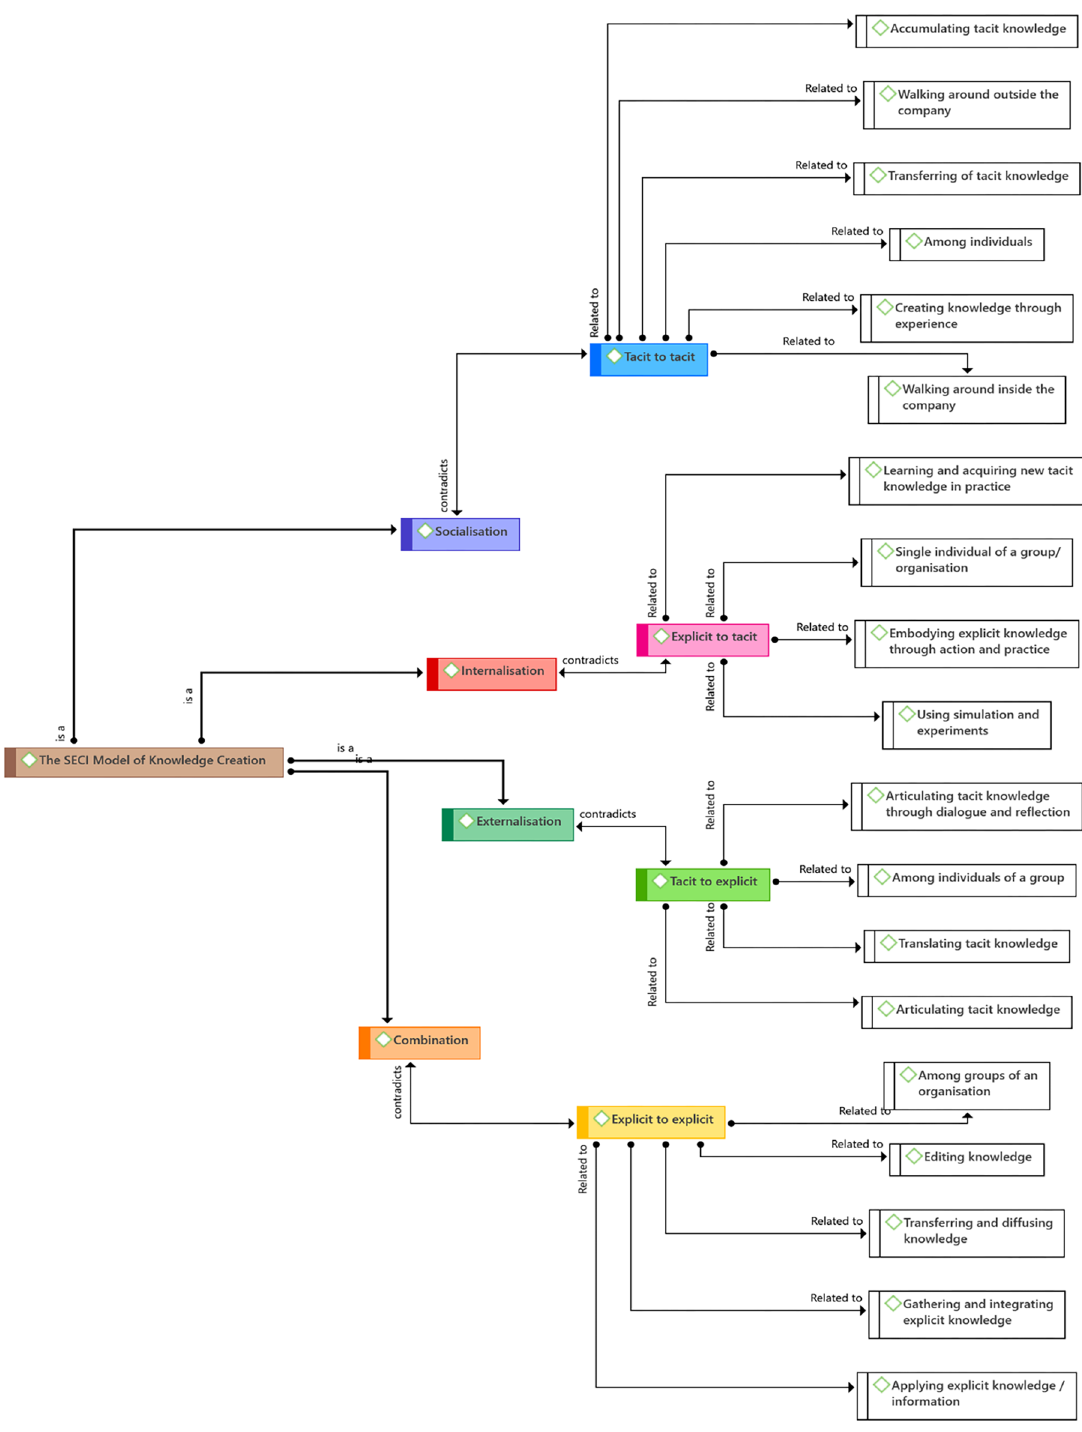
Figure 4. Atlas.ti network view on the (SECI) model of knowledge